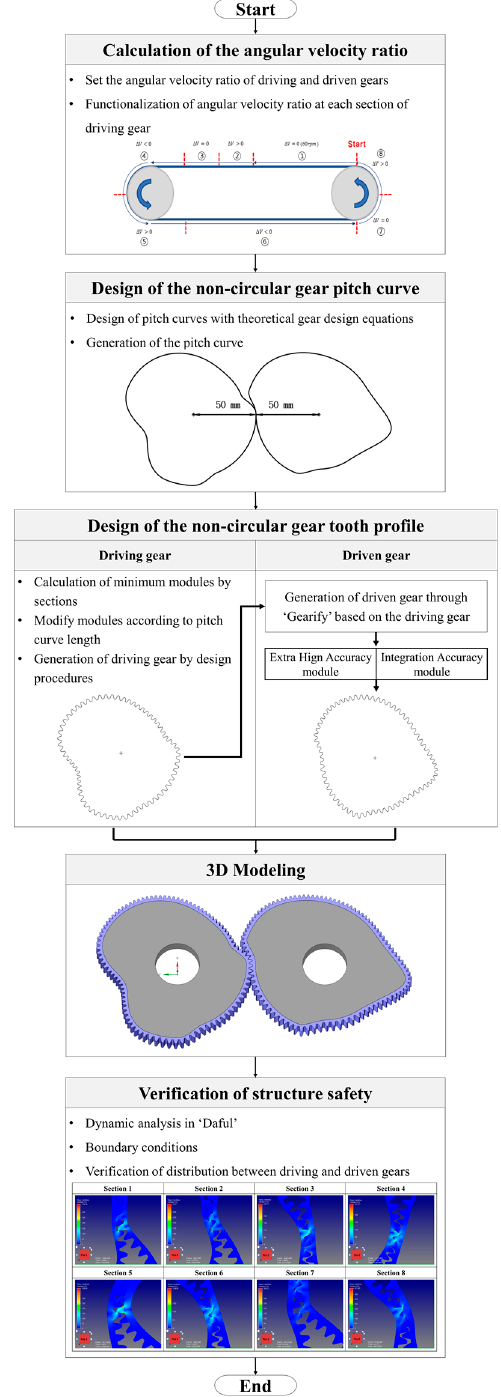
Figure 2. Configuration of non-circular gear design procedure.